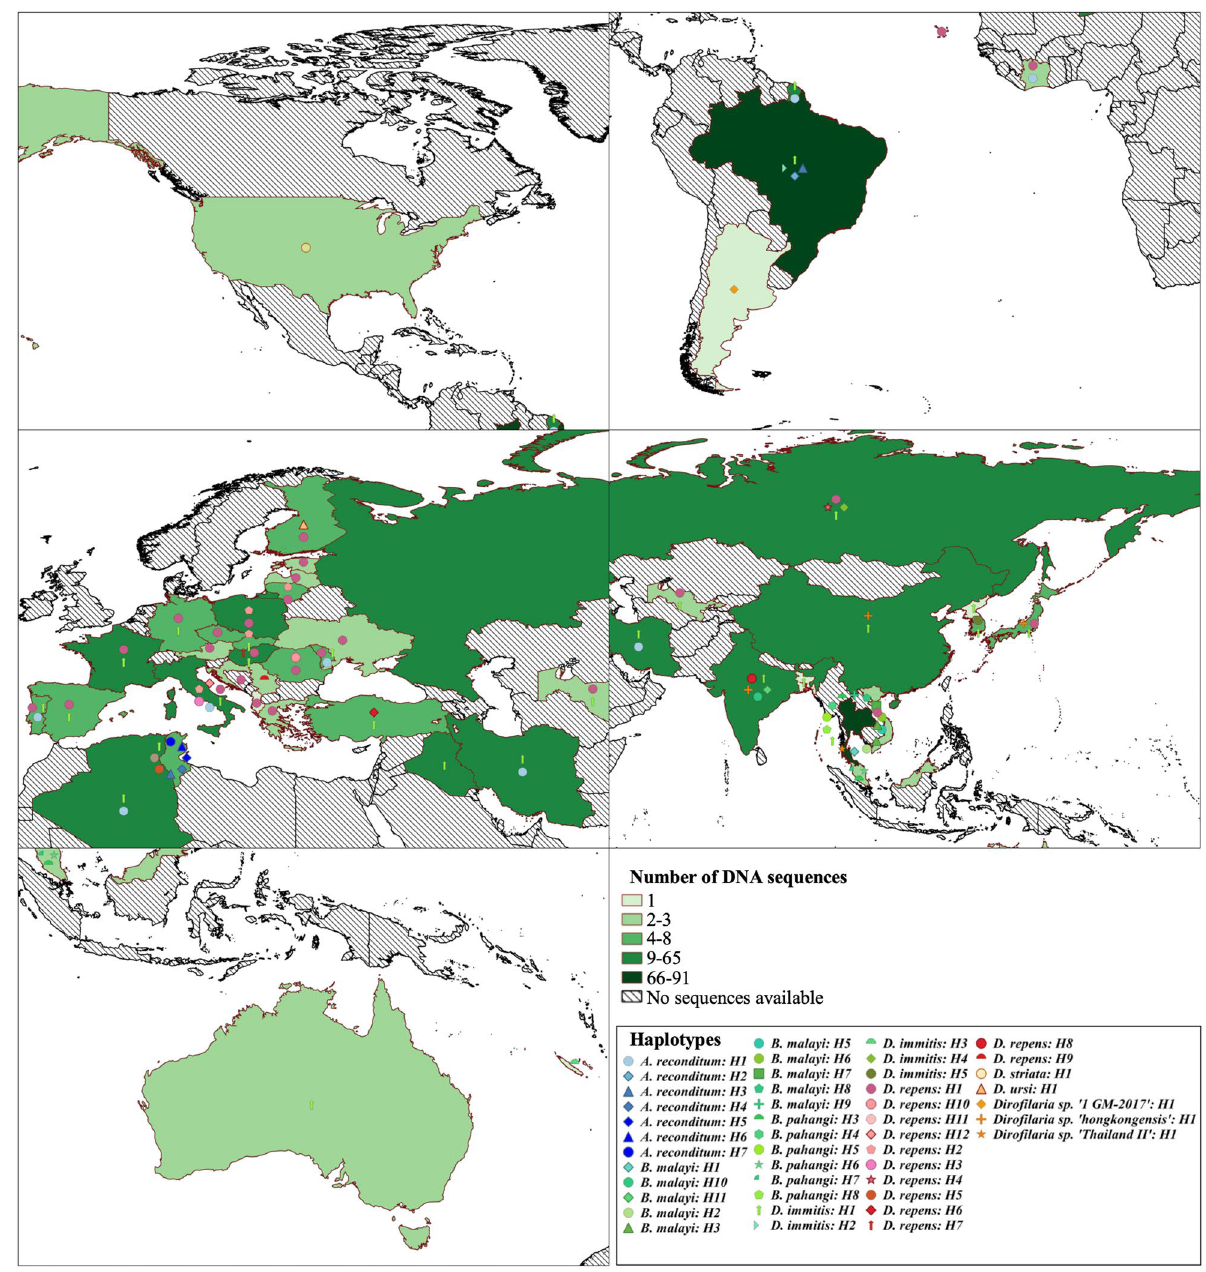
Figure 5. Geographical plotting of the zoonotic onchocercid haplotypes using the QGIS software (version 3.0.0, http:// qgis. osgeo. org) 25 . The choropleth map (color-gradient map) represents the availability of DNA sequences per each country. Haplotypes for each species are plotted using country centroids and the point displacement